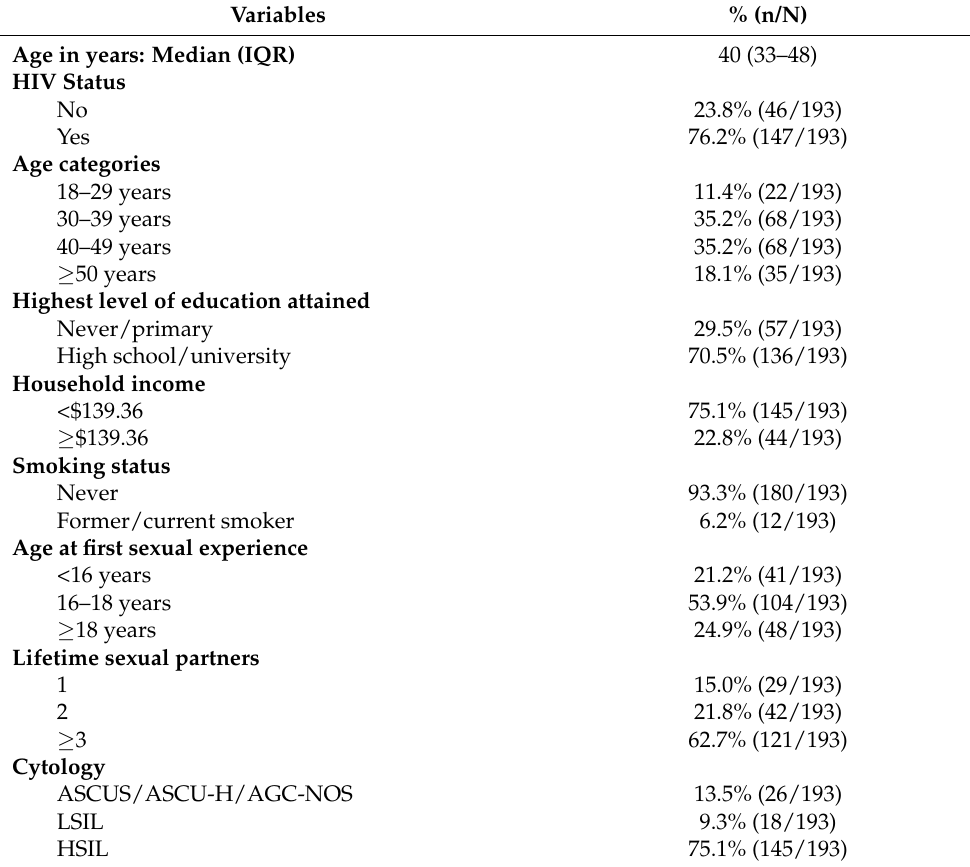
Table 1. Demographic and behavioural characteristics of study participants.